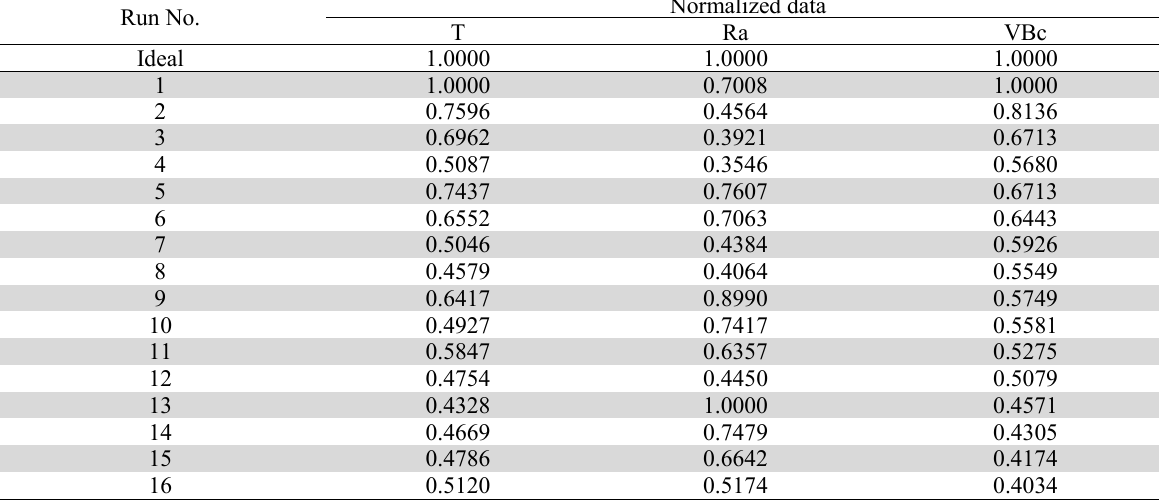
Normalized data of experimental results in SIC environment Run